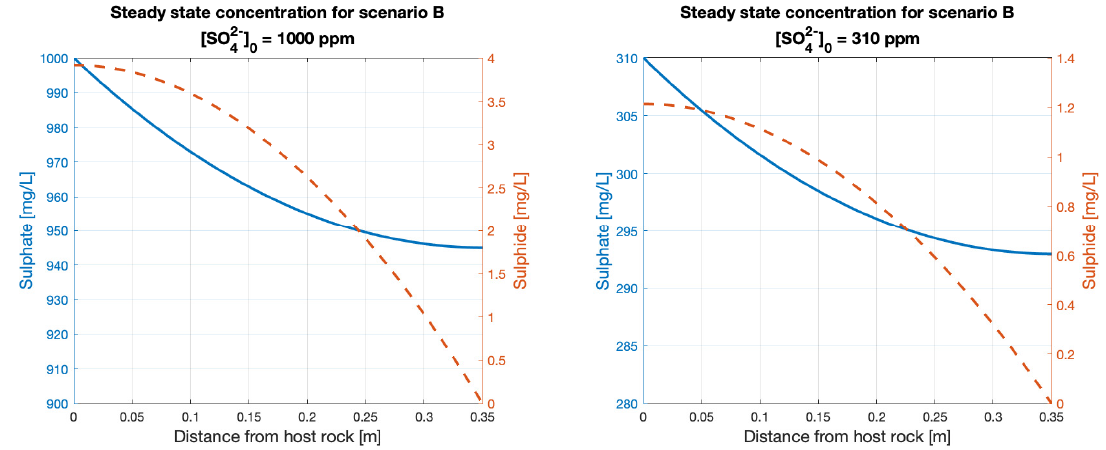
Figure A3. Profile of concentration at steady state for Scenario A, vertical line shows the boundary between the gapfill bentonite and the HCB.